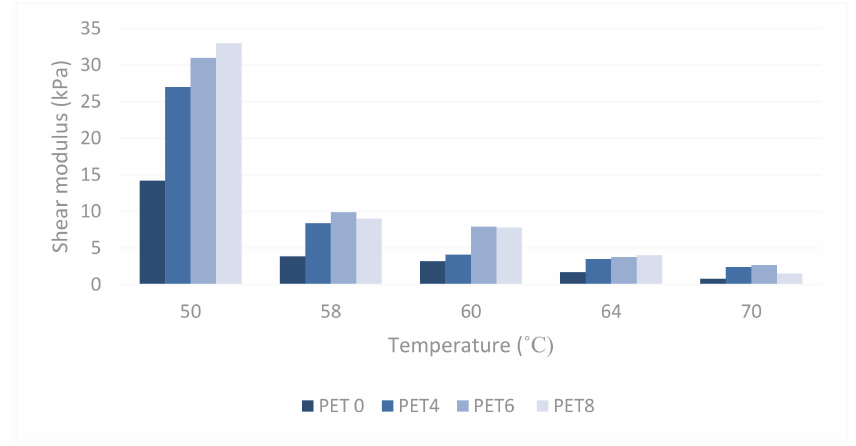
Figure 4. Complex shear modulus results of PET-modified binders after RTFOT.